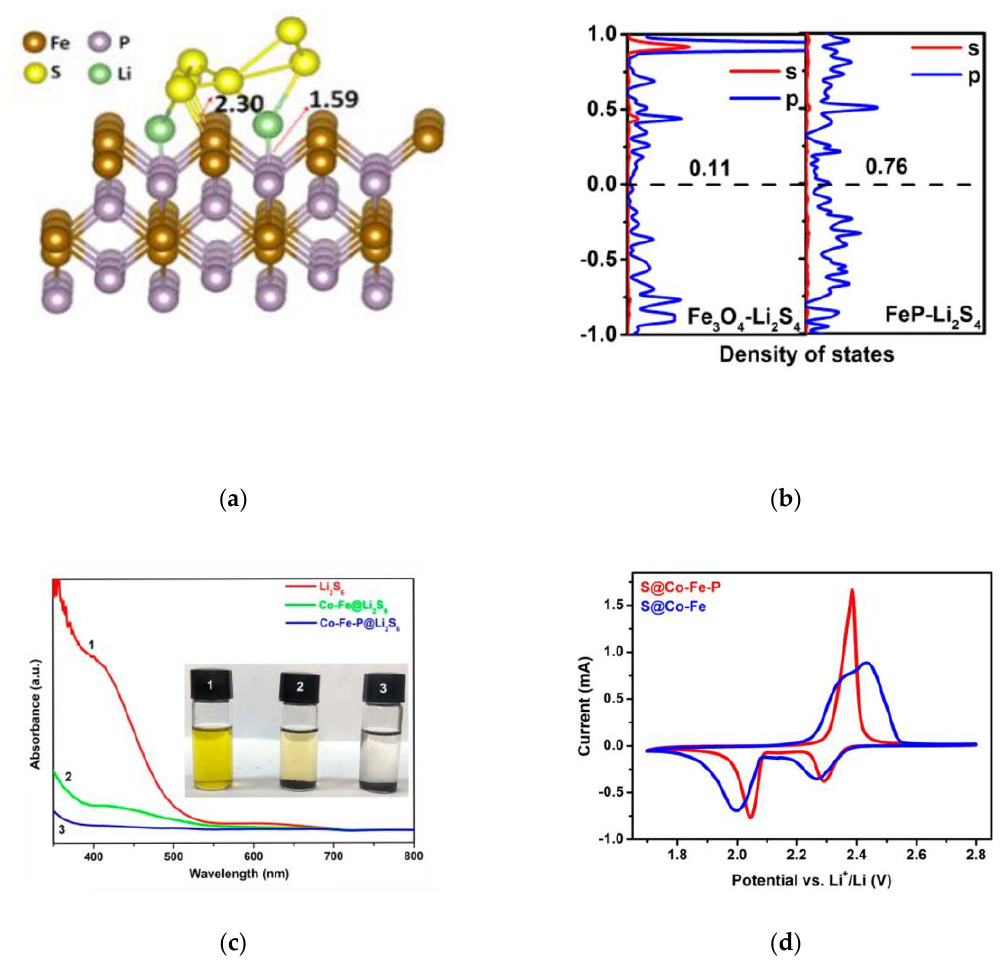
Figure 6. ( a ) Geometry of Li 2 S 6 binding to the (111) plane of FeP [48] . ( b ) Density of states analysis of s bands and p bands of Li 2 S 4 in Fe 3 O 4 (111)−Li 2 S 4 and FeP(211)−Li 2 S 4 systems [49] . ( c ) UV−Vis adsorption spectra of a Li 2 S 6 solution before and after the addition of Co−Fe or Co−Fe−P powder. The inset shows the digital photo of Li 2 S 6 solution before and after the addition of Co−Fe or Co−Fe−P powder [50] . ( d ) The second-cycle CV curves of the S@Co−Fe−P and S@Co−Fe cathodes at 0.1 mV s −1 [50] .